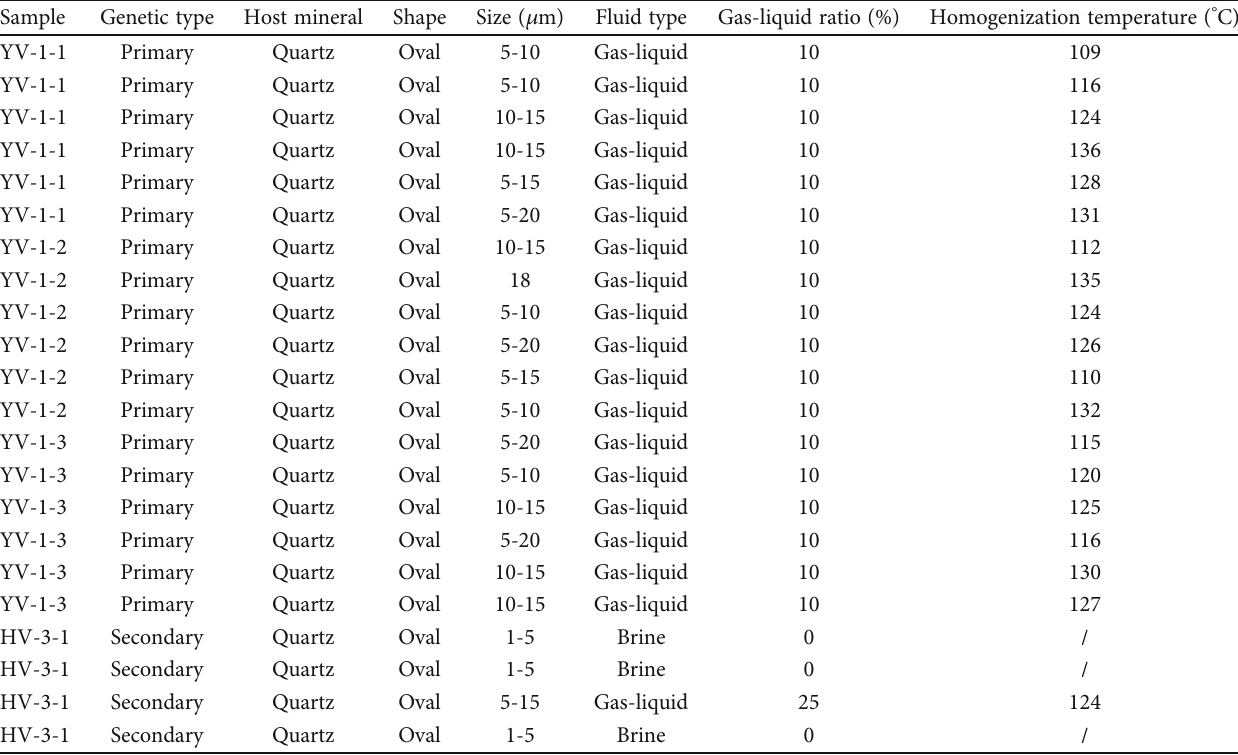
Table 3: Characteristic parameters of the fl uid inclusions within the Longtan tight sandstones in west Guizhou. Sample Genetic